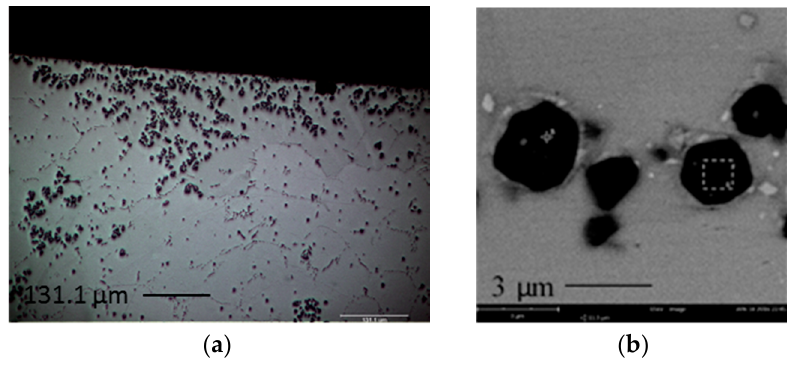
Figure 3. ( a ) Optical microscope cross sectional images SAC105 + 0.5Al near top surface of the solder after 1 × reflow and ( b ) FESEM images of equiaxed but faceted IMCs found at cross-sectioned of SAC105 + 0.5Al.